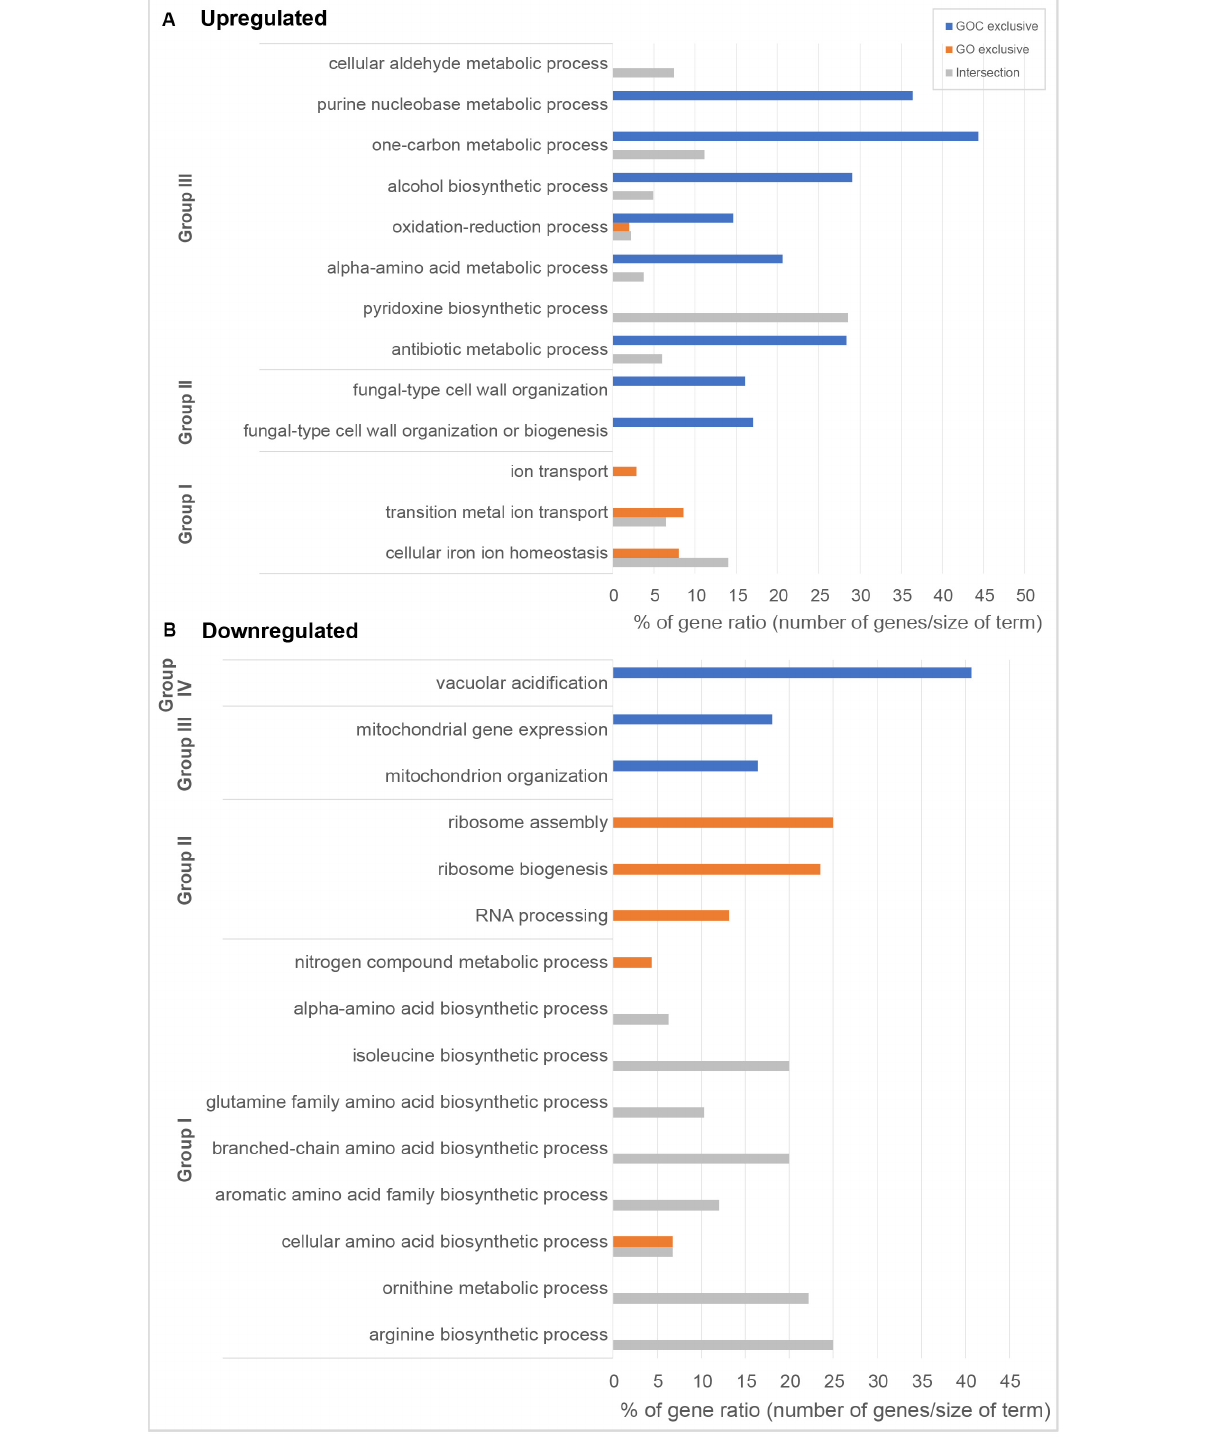
Frontiers in Microbiology |